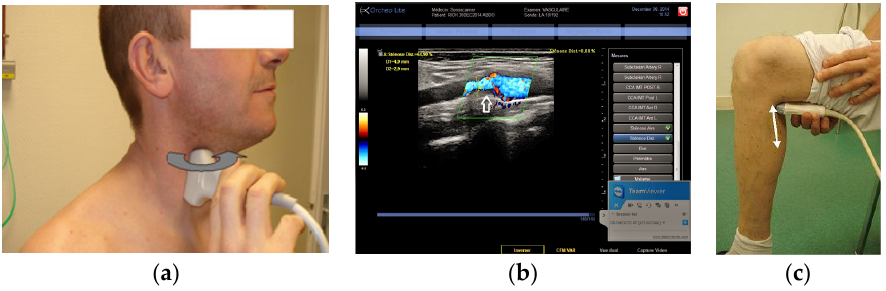
Figure 5. ( a ) Remote guidance (RG) for carotid artery; ( b ) View of a carotid stenosis in color Doppler by RG; ( c ) Location of the probe for calf vein visualization with RG.